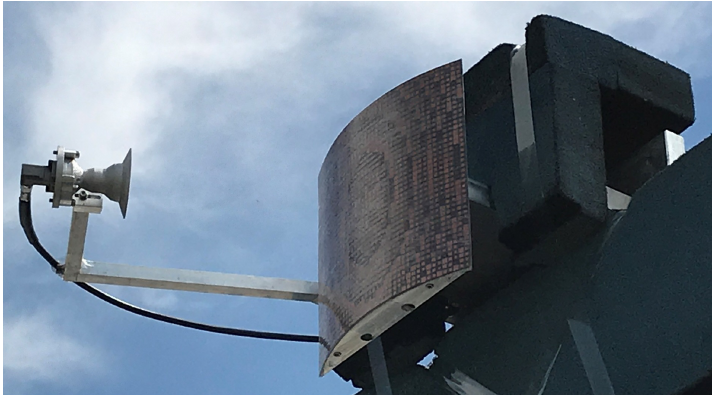
Figure 7. Photo of the entire CRA system mounted on the outdoor test range at Politecnico di